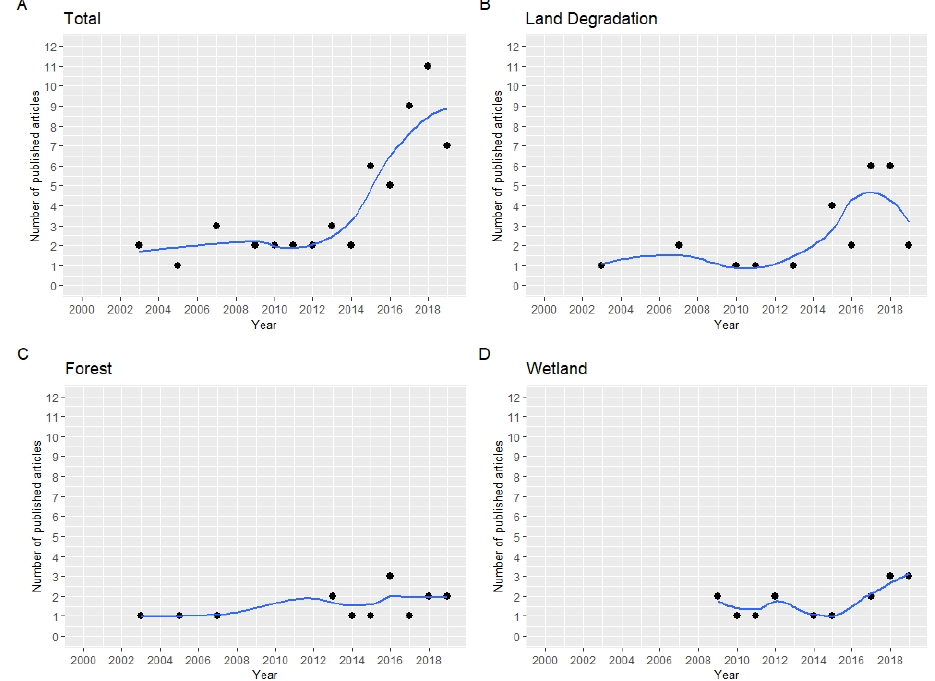
Figure 3. ( A ) Number of articles on SDG 15 components, ( B ) land degradation, ( C ) forest, ( D ) wetland, using remote sensing published each year between January 2000 and August 2019.